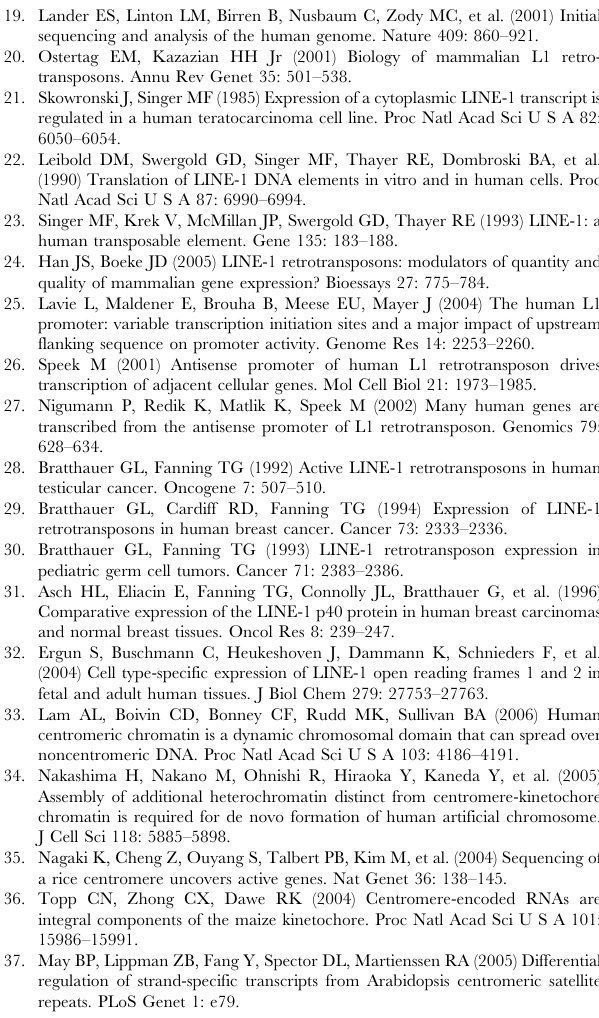
Table S3 Sequence characteristics and transcription status of L1s within a 6-Mb genomic region of the 10q25 neocentromere.